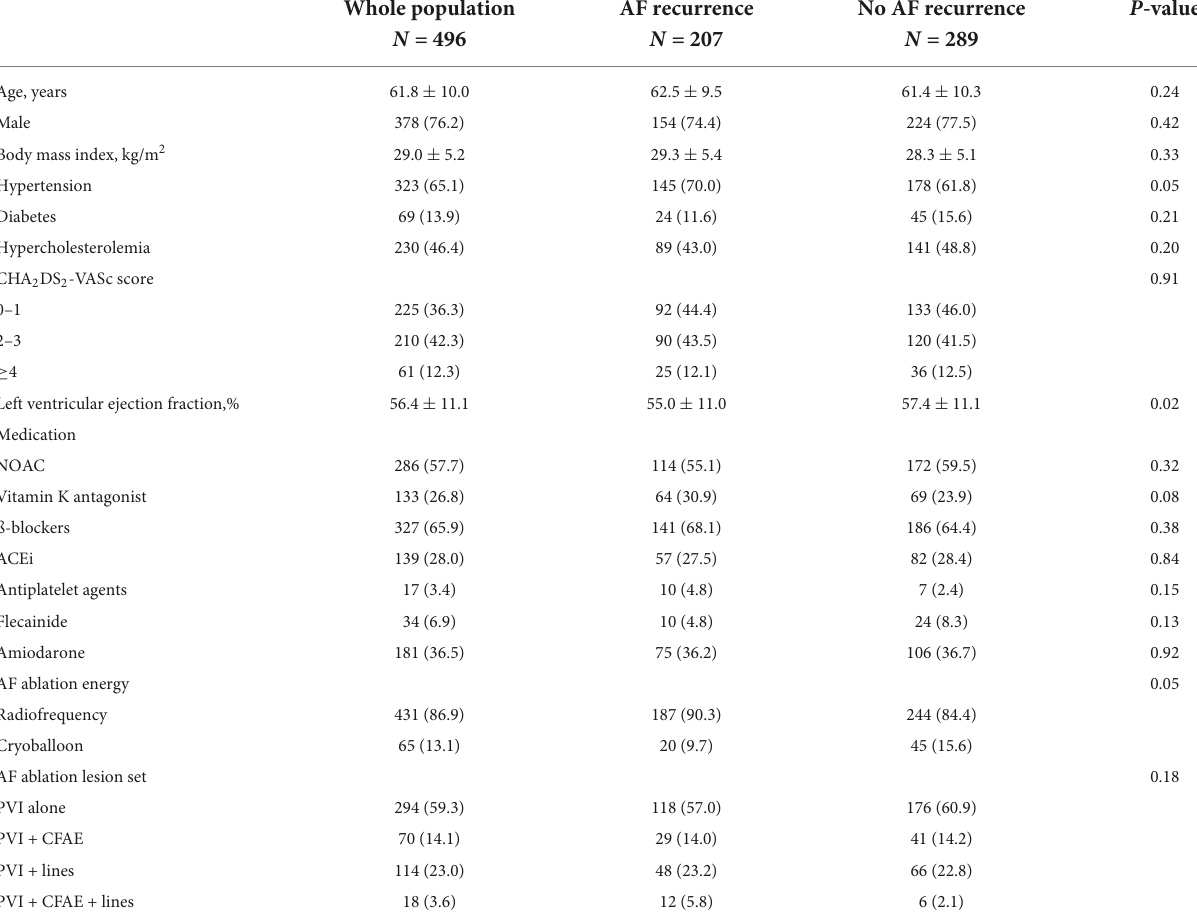
TABLE 1 Baseline